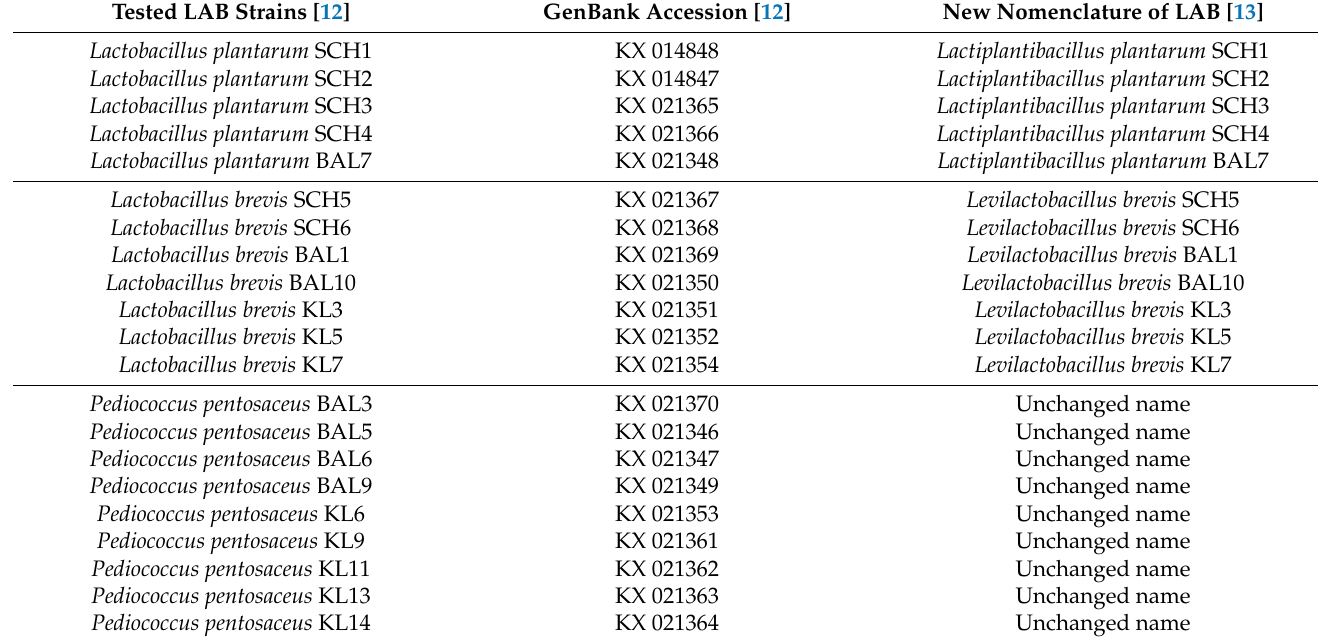
Table 1. The tested LAB strains and new nomenclature of